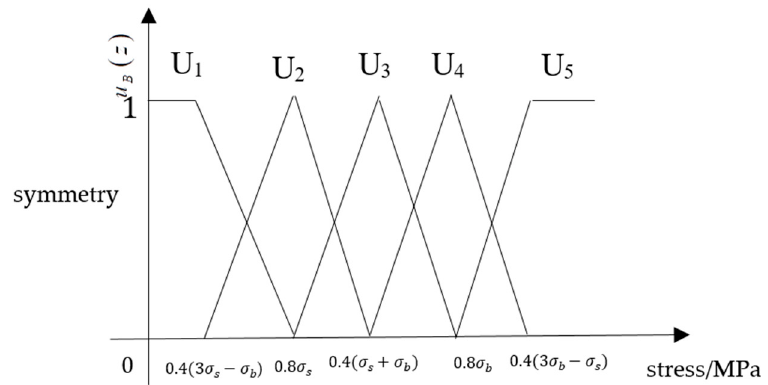
Figure 8. Function of different fragility levels.